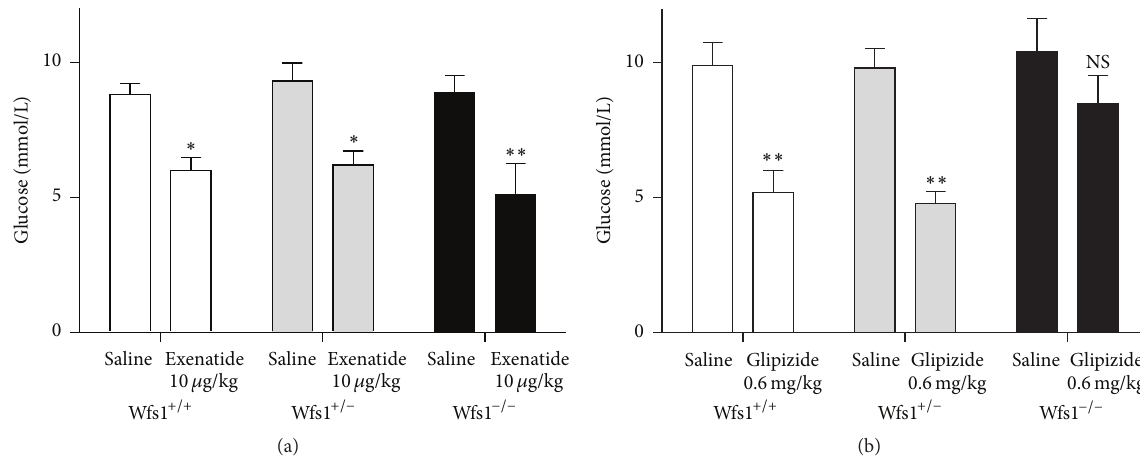
Figure 2: Effect of treatment with exenatide (a) and glipizide (b) on blood glucose level. Wfs1 +/+ , white bars; Wfs1 +/− , grey bars; Wfs1 −/− , black bars. Two-way ANOVA was used, followed by Duncan post hoc test, where ∗ 𝑝 < 0.01 versus saline; ∗∗ 𝑝 < 0.001 versus saline. 𝑛 = 8 in all